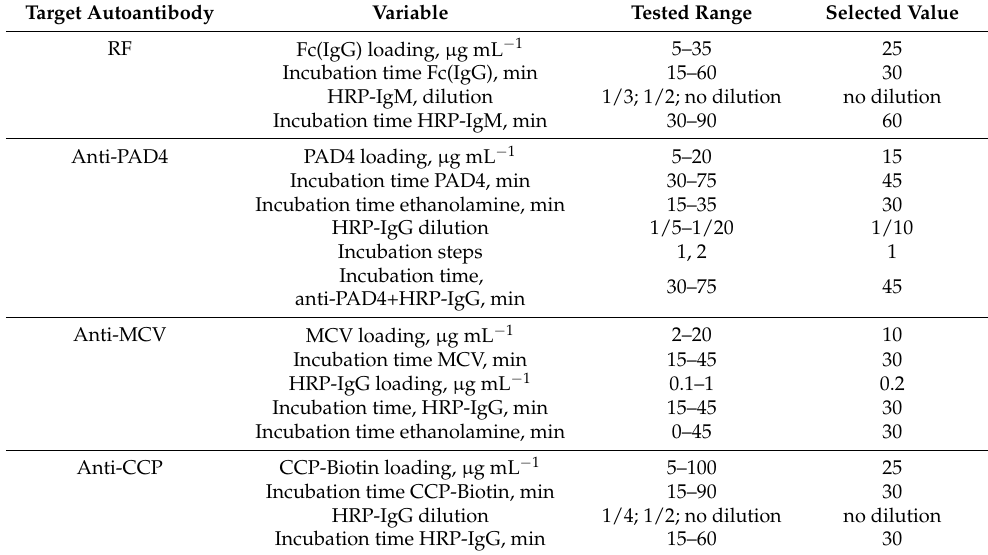
Table 1. Experimental variables selected for the simultaneous determination of RF, anti-PAD4, anti-MCV, and anti-CCP with the developed quadruple immunoplatform. Target